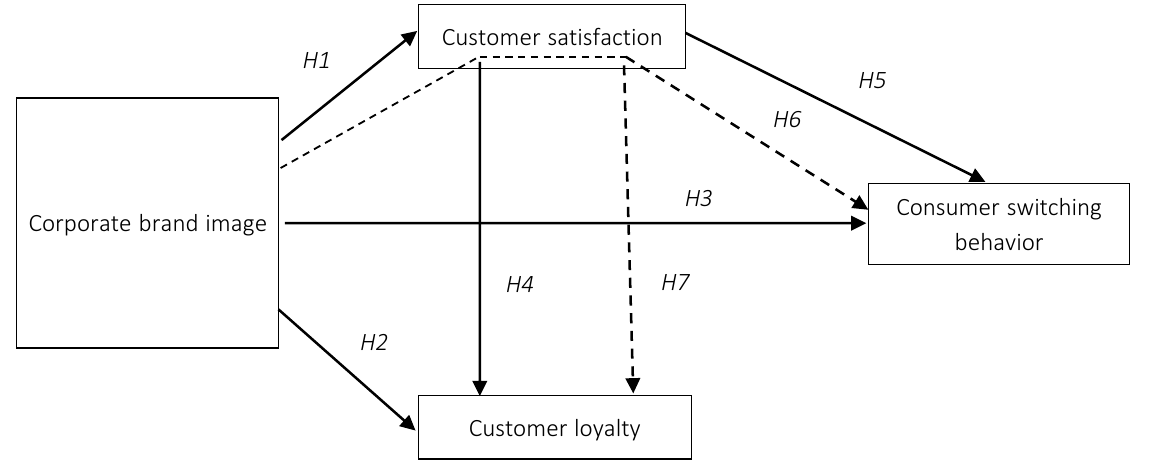
Figure 1. Conceptual framework that was validated in this